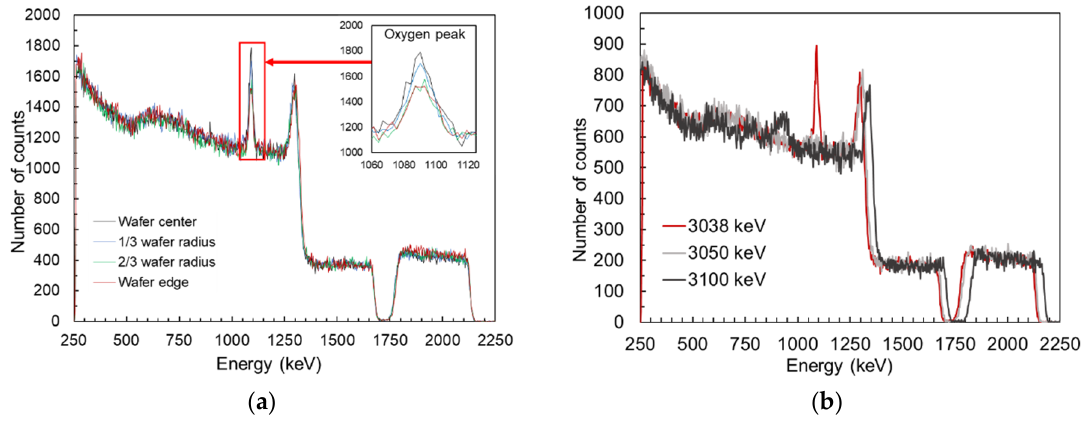
Figure 7. ( a ) NRBS spectra taken at different wafer positions, fixing the beam energy at 3.038 MeV. The inset highlights the oxygen resonance detected when measuring at this energy [34]. ( b ) RBS-NRA spectra from wafer center taken at three different beam